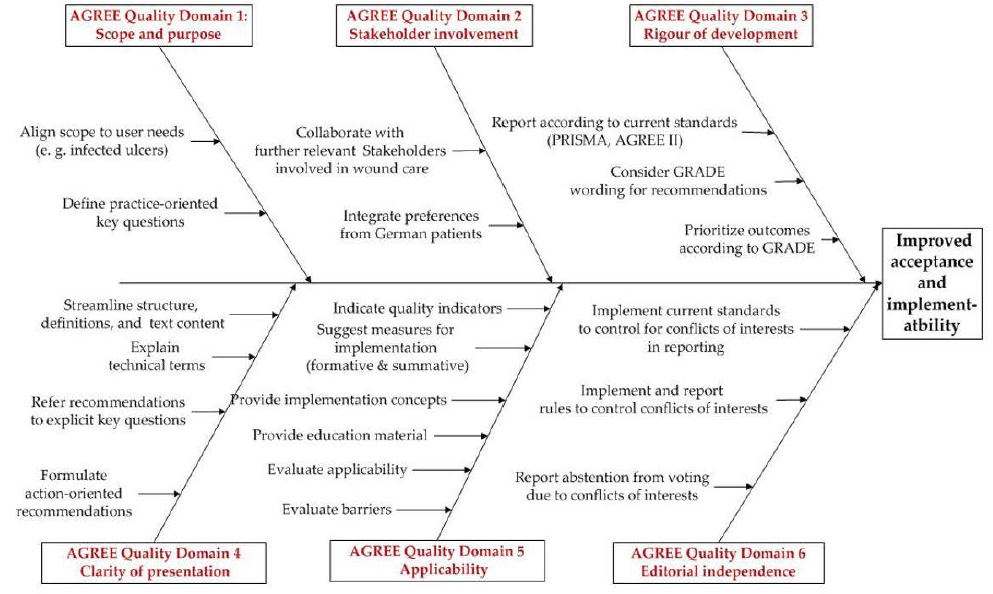
Figure 1. Framework to improve acceptance of the German DGfW-guideline (translated from